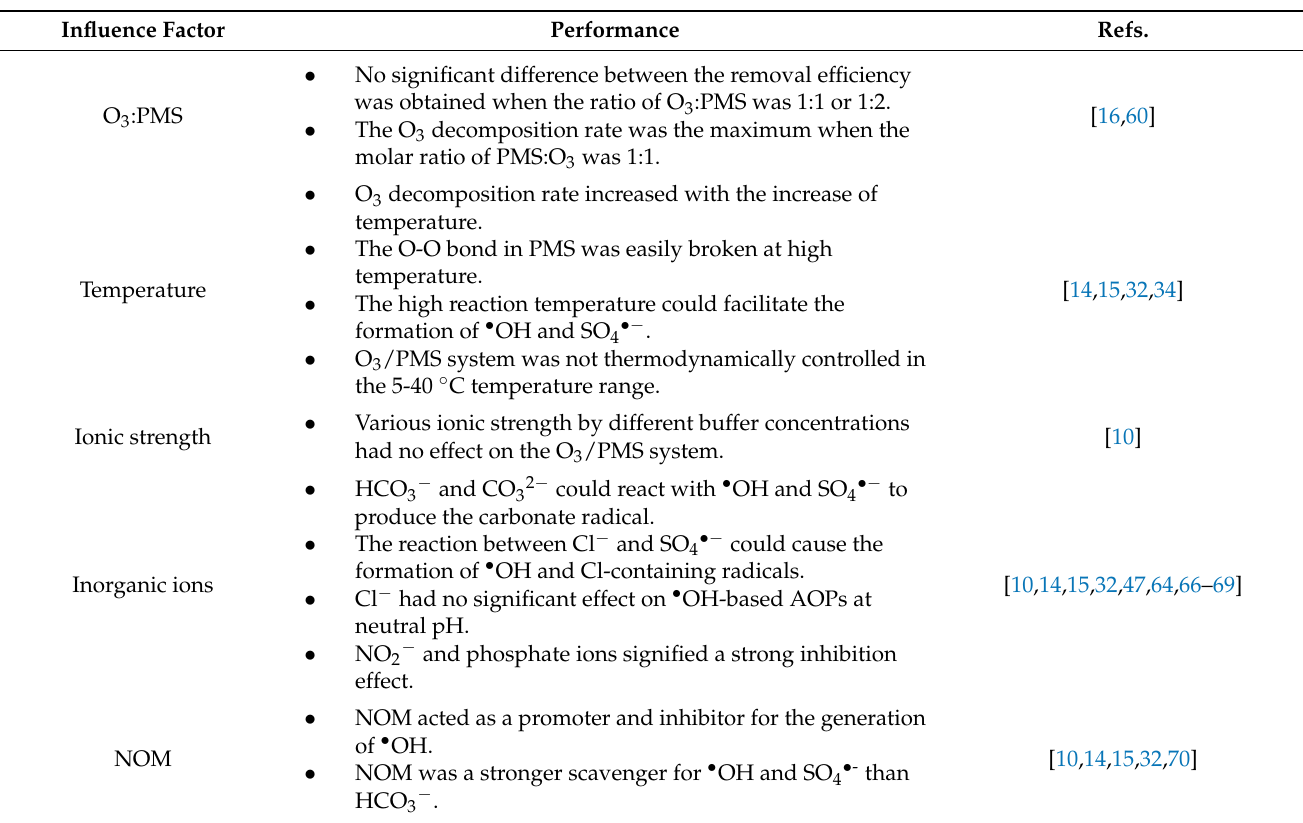
Table 1. Cont. Influence Factor Performance